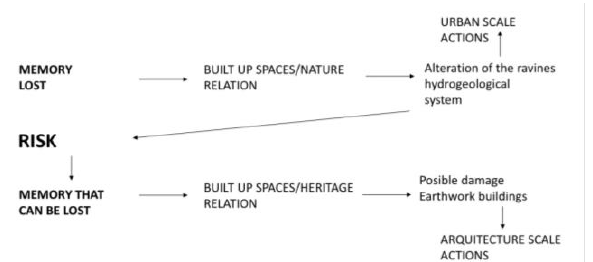
Figure 10. Relation between the loss of memory and risk. Credits: Dario